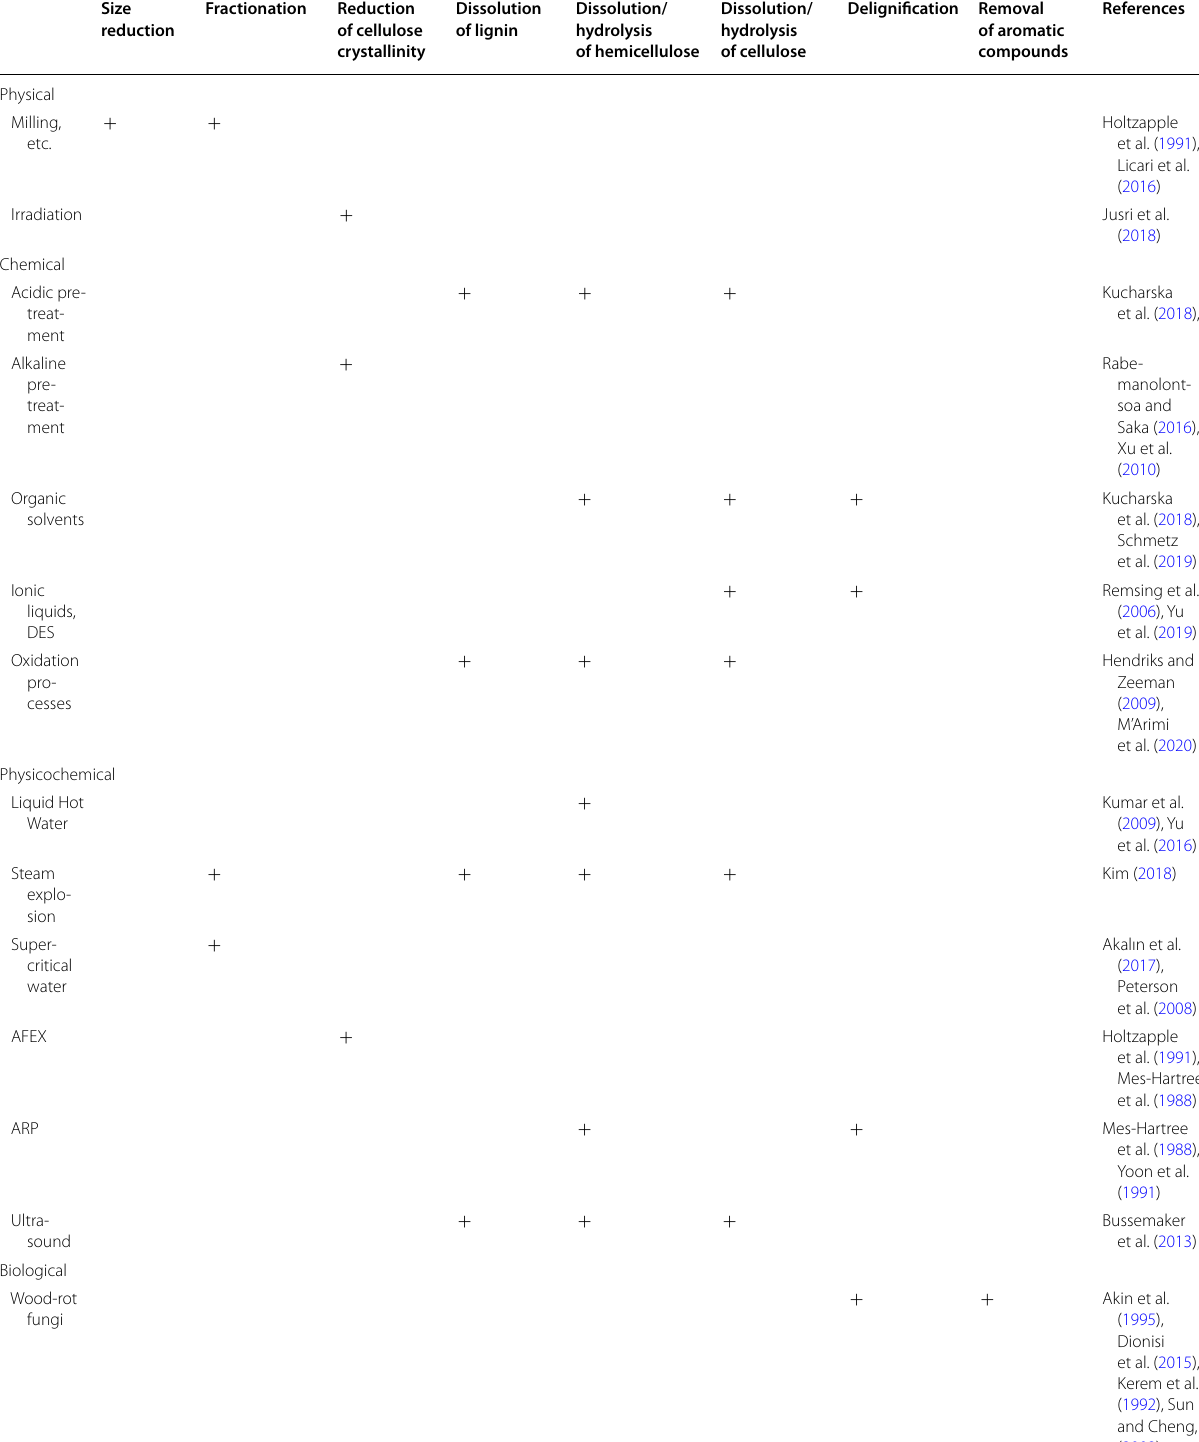
Table 2 Overview of pretreatment methods for lignocellulosic